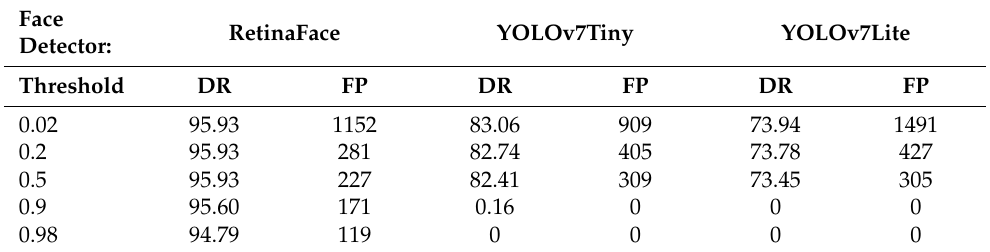
Table 2. Performance (detection rate and false positives) of RetinaFace and YOLOv7.